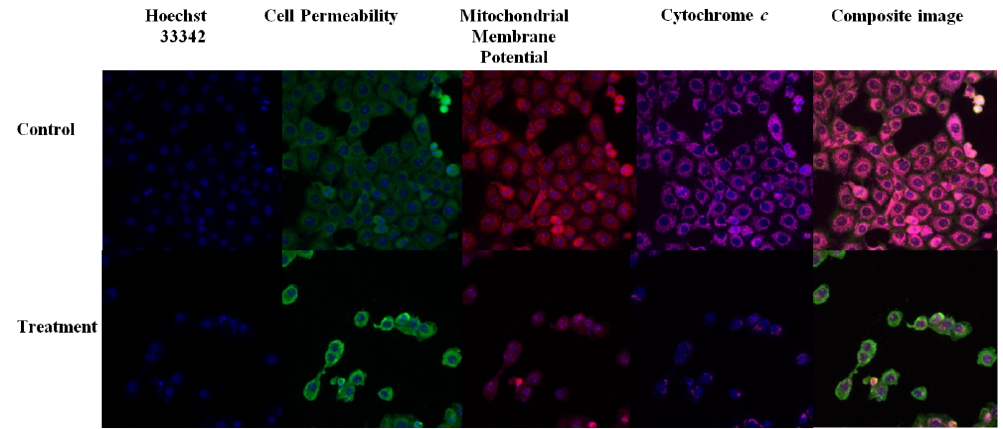
Figure 8. Representative images of MCF7 cells (×20) treated with TPHE at IC concentration. Cells stained with Hoechst 33342, cell membrane permeability, cytochrome c and MMP dyes. MCF7 cells produced a noteworthy reduction in MMP and a marked increase in chromatin condensation, cell membrane permeability and cytochrome c